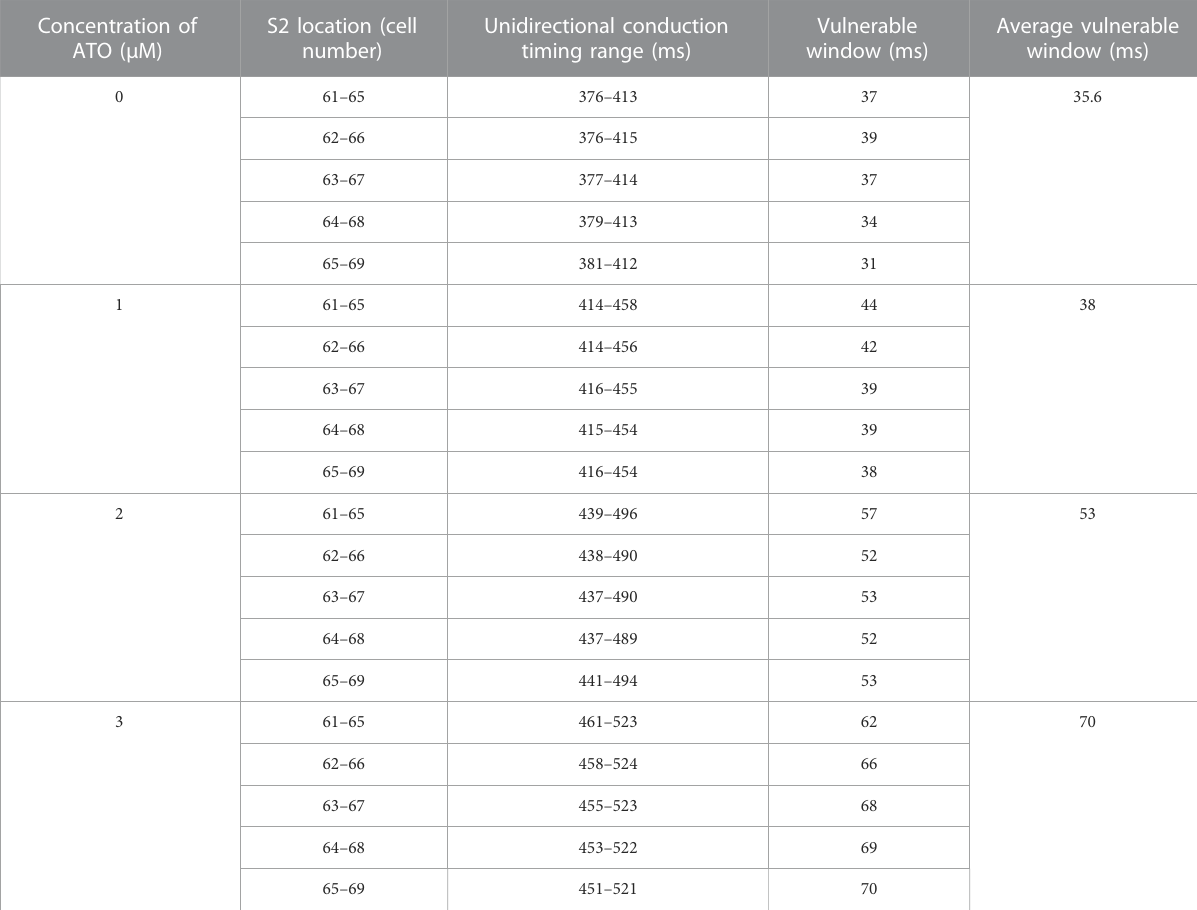
TABLE 2 Effect of ATO on VM in the ventricular cable model. Concentration of ATO ( μ